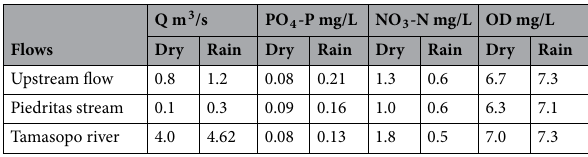
Table 1. Water quality concentration values established as inflow conditions.